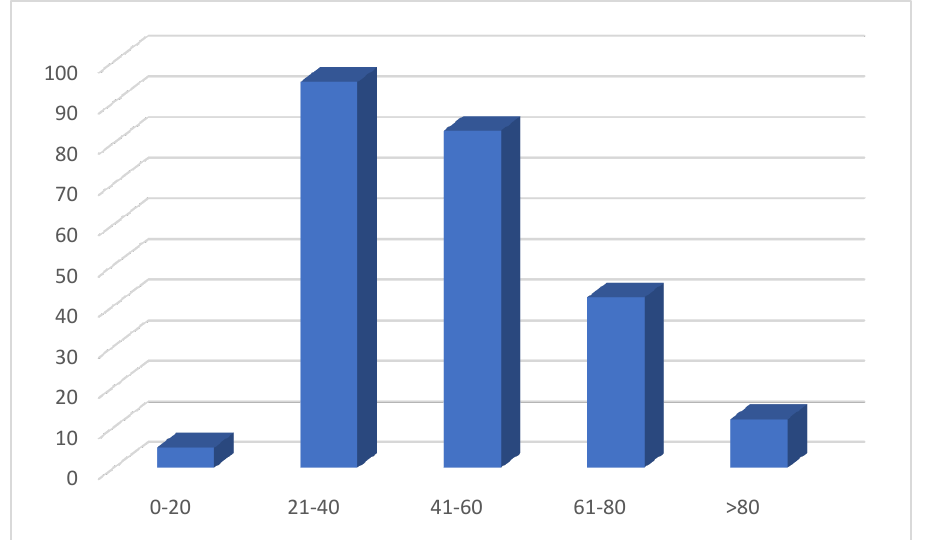
Figure 3. Distribution of cases according age.